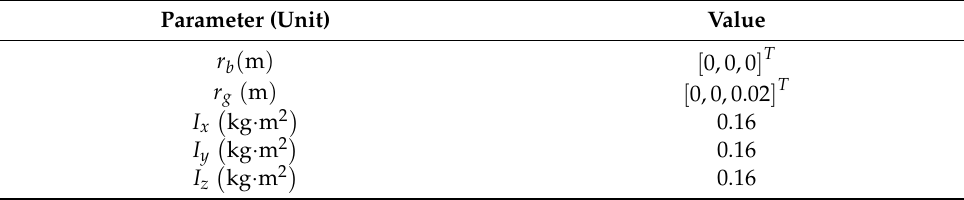
Table 3. Used parameters for the BlueROV2 simulation.